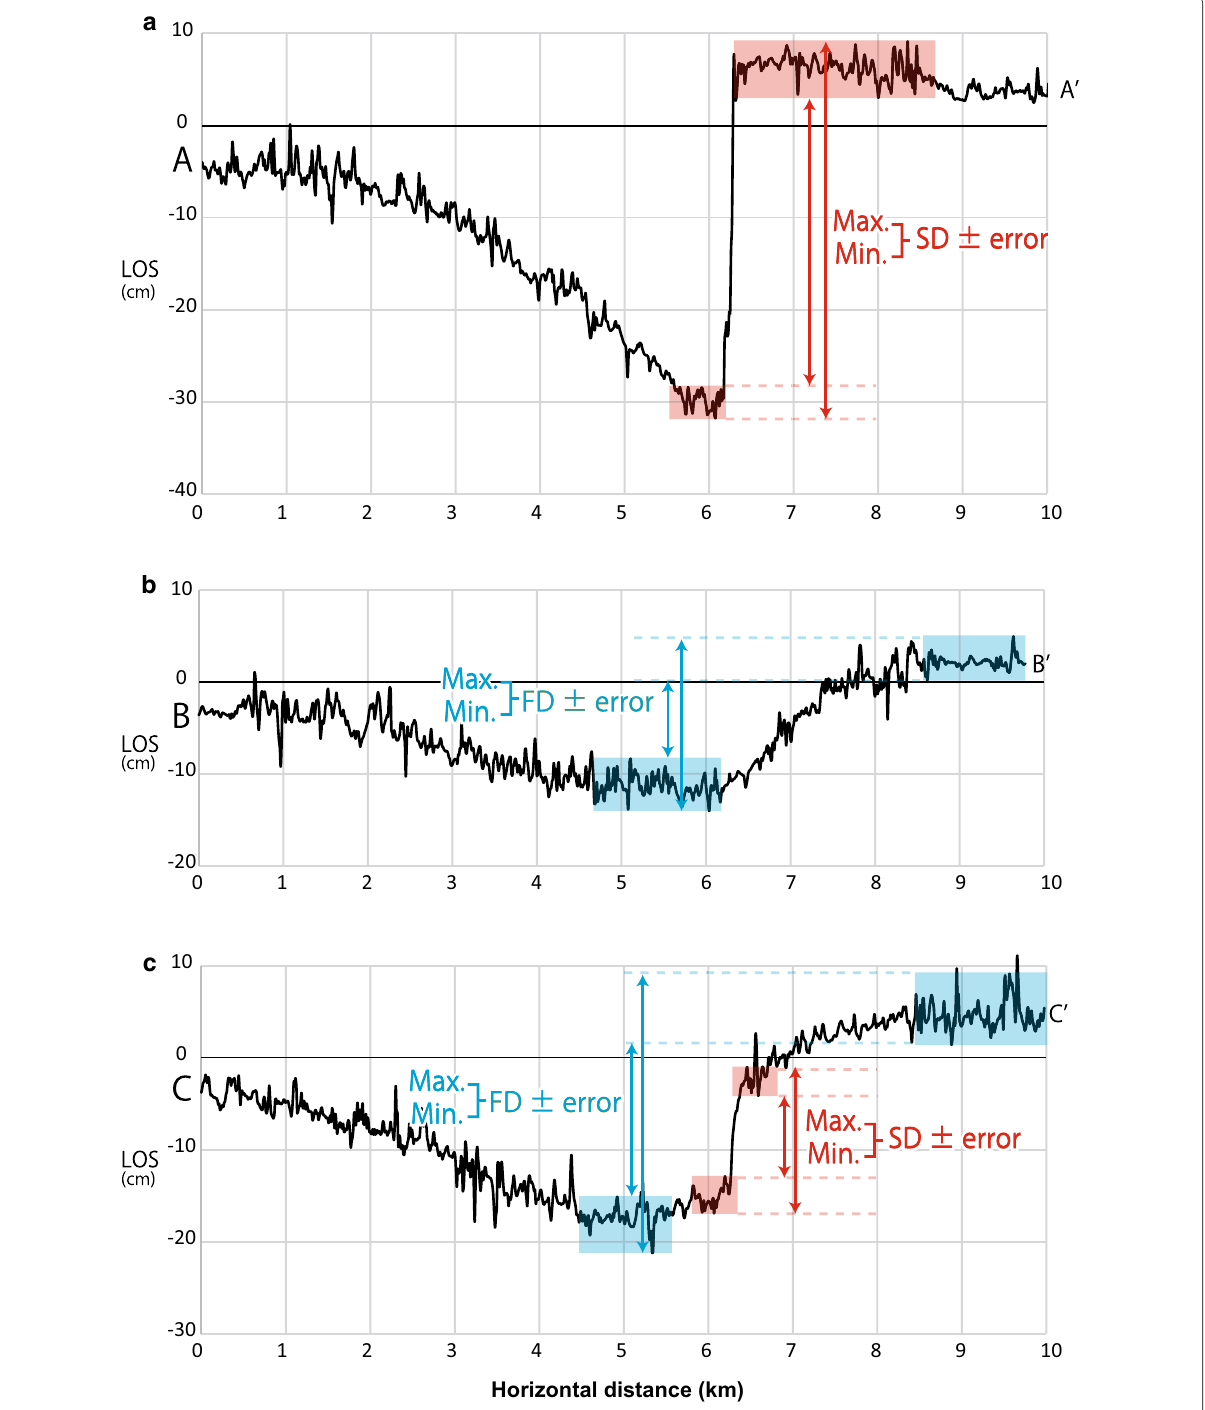
Fig. 3 Profiles of LOS surface displacement from the 2016 event determined by differential InSAR analysis; locations are shown in Fig. 2b. a SD (surface displacement), b FD (flexure displacement), and c SD